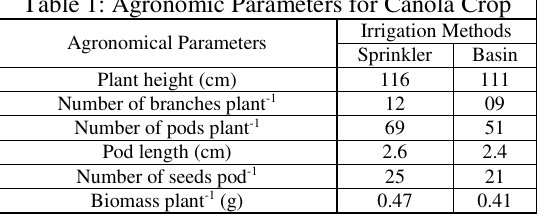
Table 1: Agronomic Parameters for Canola Crop Agronomical Parameters